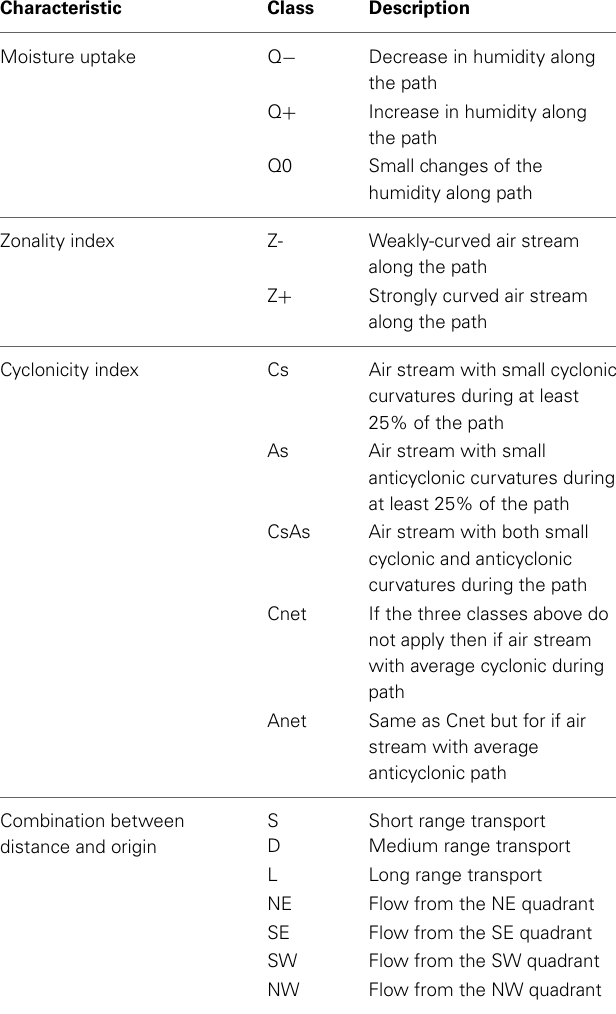
Table 2 | Characteristics and respective classes used to classify the representative air